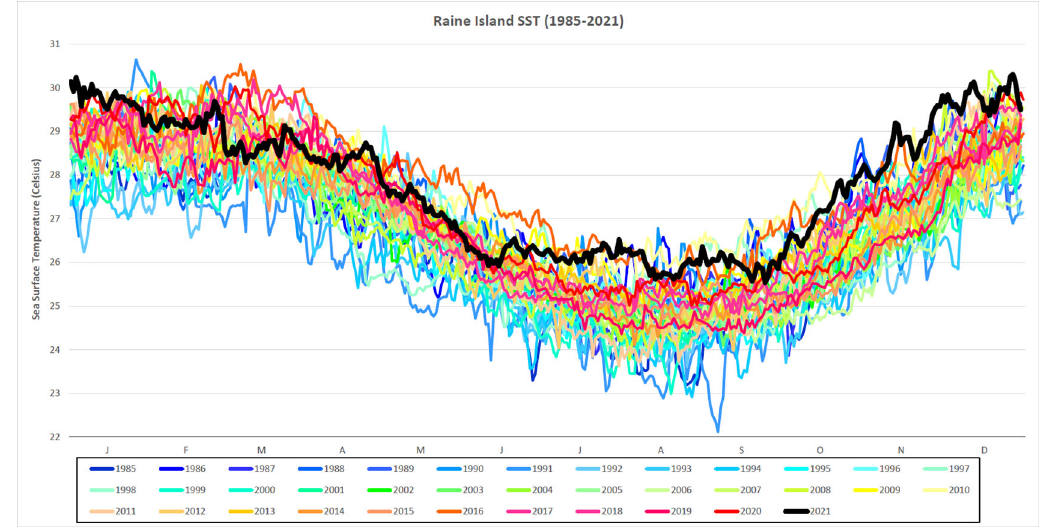
Figure 2. Daily SST for Raine Island from 1985-2021. Daily SST (degrees Celsius) from 1985-2021 for a single 5 km-resolution satellite pixel (0.05 ° (cid:1) 0.05 ° ) located in the northern Great Barrier Reef, Raine Island (11.589 ° S, 144.035 ° E). SST for 2021 is in black and in bold.